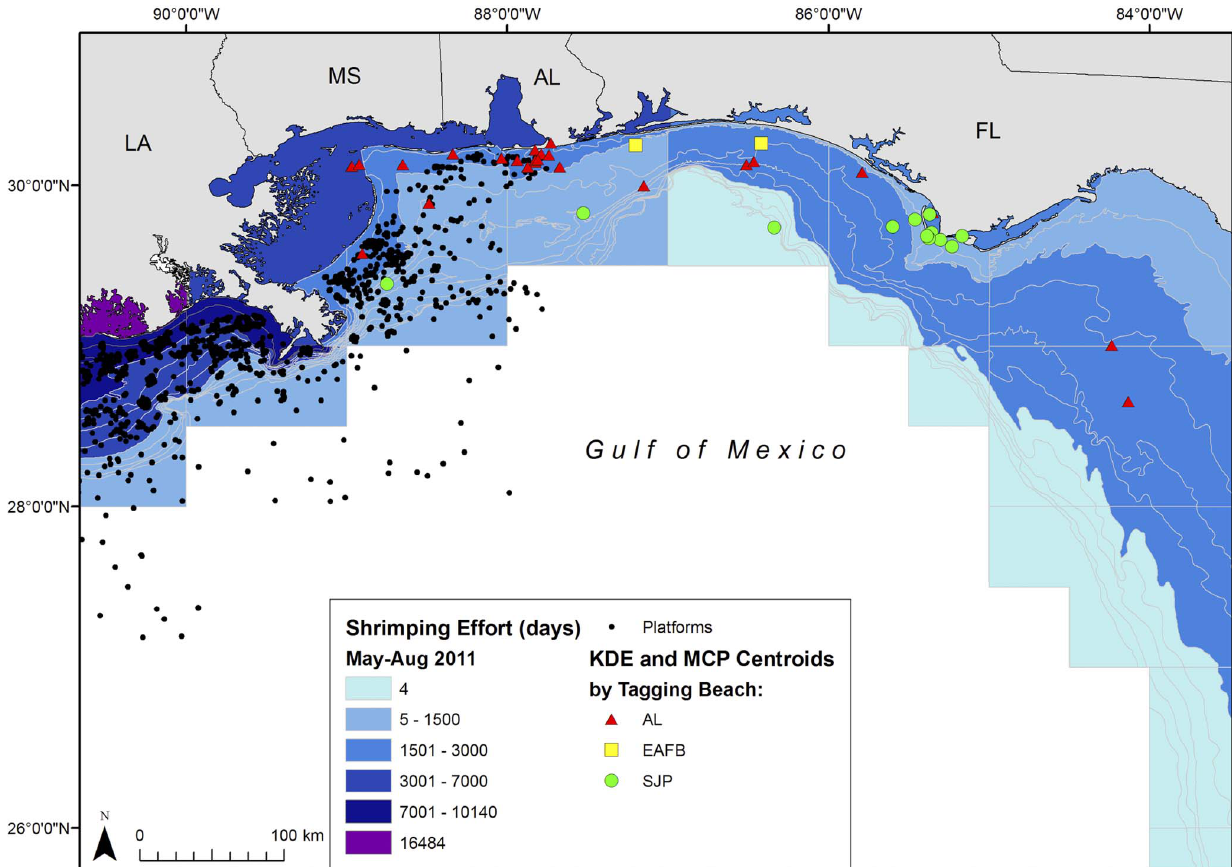
Figure 7. Centroid locations for inter-nesting habitat used by loggerheads ( Carettacaretta ) in the Northern Gulf of Mexico; kernel density estimates (KDE) and minimum convex polygon (MCP) centroids are shown in relation to active oil and gas platforms (black dots; data from www.data.boem.gov ), and shrimp trawling effort (days; data provided by NOAA) from May to August 2011. Turtle tagging locations are distinguished by symbols as in legend.